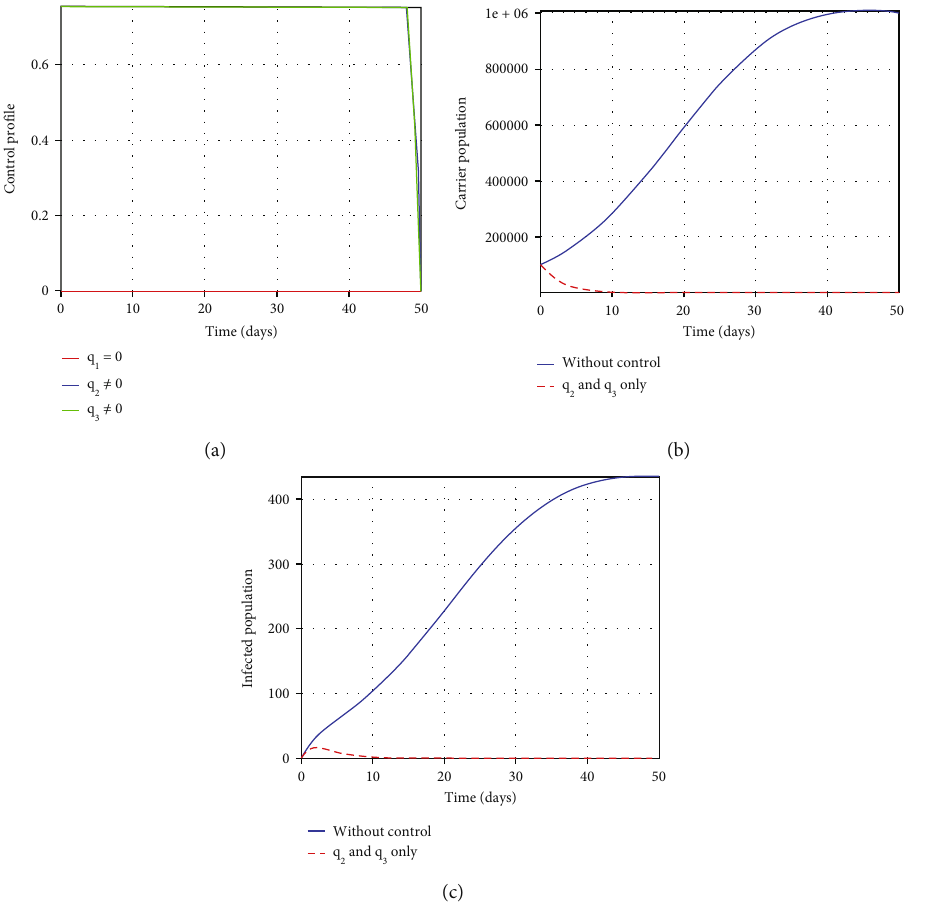
Figure 11: E ff ect of using both treatment and personal protection only. The control pro fi le in (a) shows the impact of early treatment and adherence of personal protection techniques in the population. About 80% of individuals are required to receive treatment and personally protect themselves to help eradicate the meningitis disease. The graphs clearly show the impact and e ff ectiveness of both treatment and personal protection in averting the number of (b) carriers and (c) infected